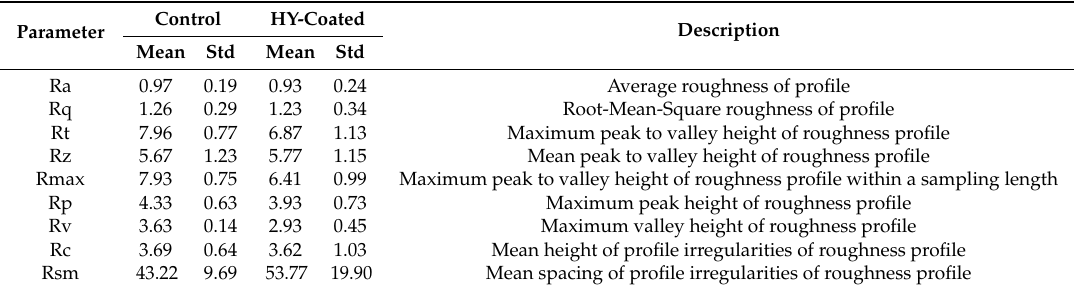
Table 1. Roughness parameters obtained by stereo-SEM. Data are expressed in µm as average and standard deviation of three measurements.